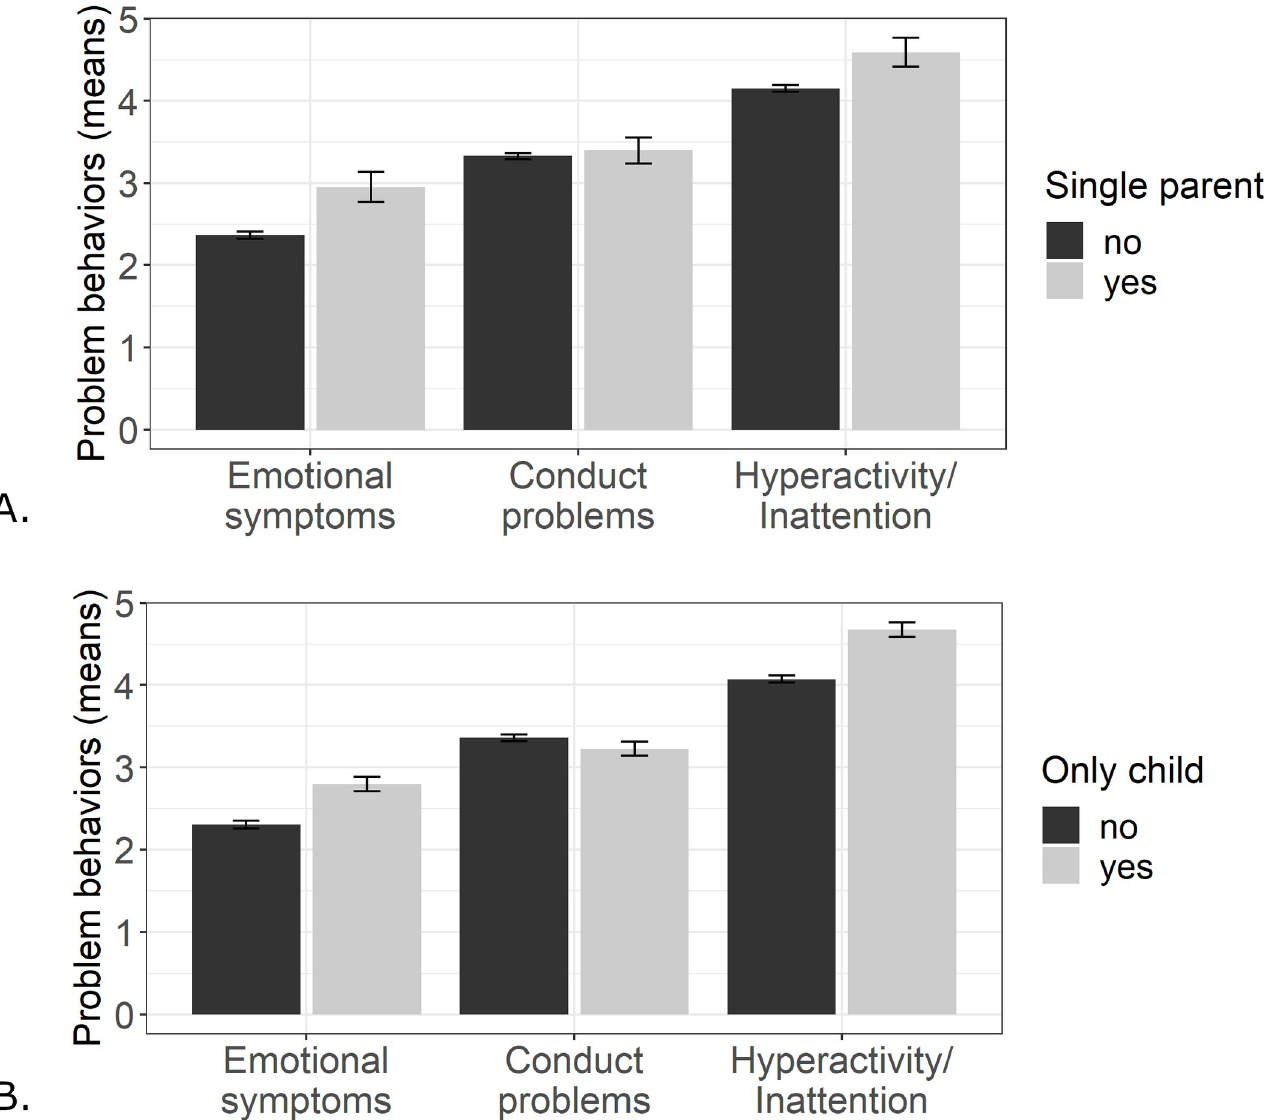
Fig 5. Means of problem behavior on each subscale across children. A: Children divided by their family background (single parent; not-single parent). B: Children divided by their sibling status (only child; not-only child). https://doi.org/10.1371/journal.pone.0253473.g005 situation (apartment/house, balcony, small garden, large garden) by adding these variables as separate predictors. For these regressions, we excluded 10 children of diverse gender or for whom gender was not reported and 27 children whose caregiver replied ambiguously about their housing situation. The results of the regressions are presented in Table 2. Children from single parent families showed more emotional symptoms compared to children from not-sin- gle parent families. Likewise, only children showed more emotional symptoms and hyperactiv- ity/inattention than children with siblings. Less hyperactivity/inattention was reported for children living in a house ( M = 4.01, SD = 2.29) compared to children living in an apartment ( M = 4.38, SD = 2.33). Children, who had a large garden at home, showed less hyperactivity/ inattention ( M = 3.93, SD = 2.27) and less conduct problems ( M = 3.23, SD = 2.10) compared